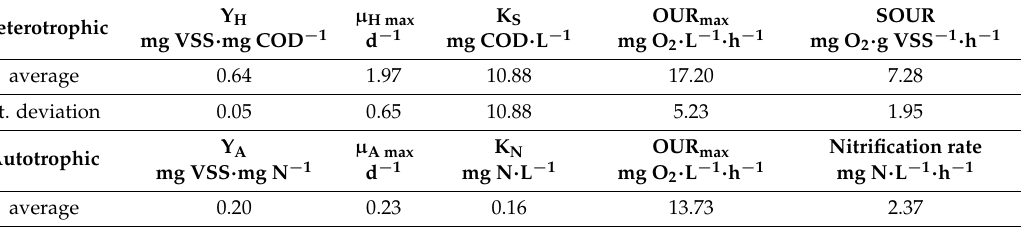
Table 3. Kinetic and stoichiometric parameters.